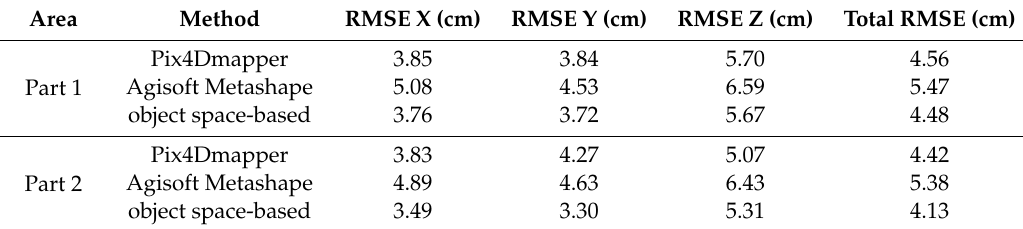
Figure 8. Placements of ground control points and check points. Table 1. Comparison of the obtained RMSE values of CPs via Pix4Dmapper 4.4, Agisoft Metashape Professional 1.5.3, and the object space-based